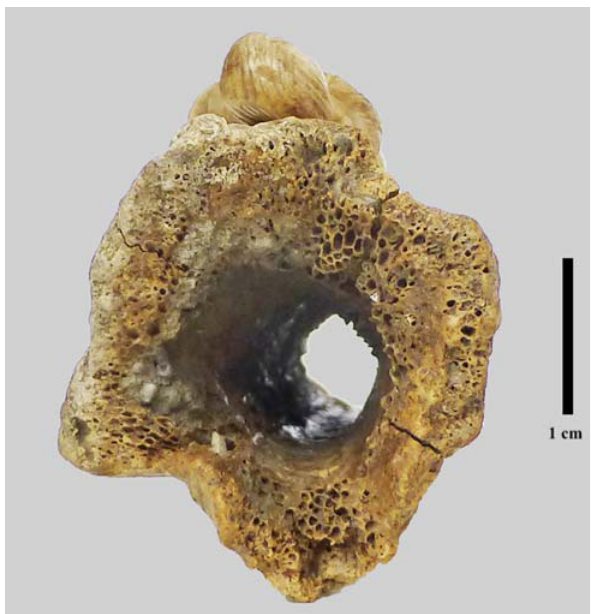
Figure 8: The fi gurine from I ž a - Leànyvàn matches the cranial side of the medial fi nger, at the proximal of the diaphysis, of a right metatarsal bone from bovid sp. , with the thickness of its head ( 0.8 – 1 cm ) and its curvature in all pro fi les. Scale, 1 cm ( Photo: Éva David ) .